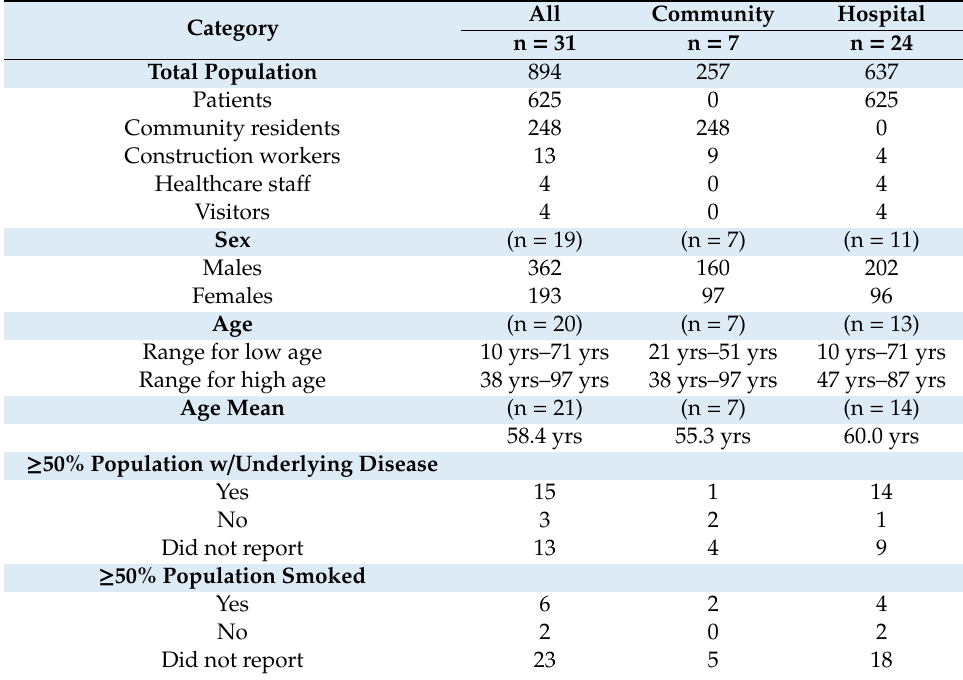
Table 3. Demographic